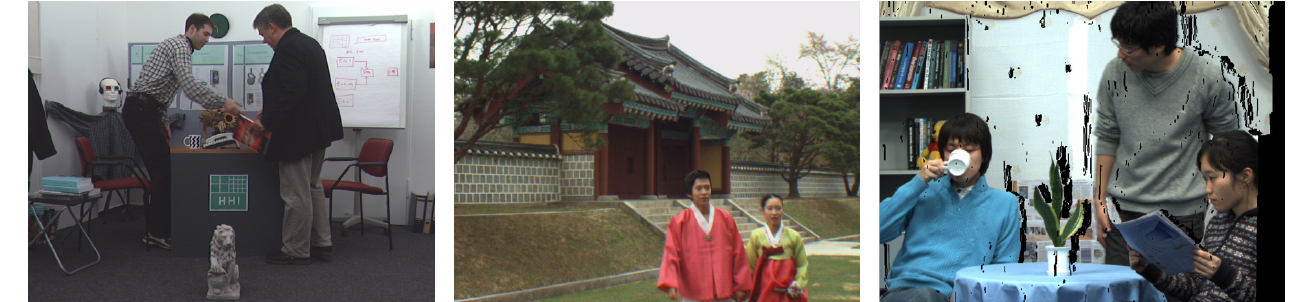
Figure 3. Examples of the DIBR-sythesized views of IRCCyN/IVC database.